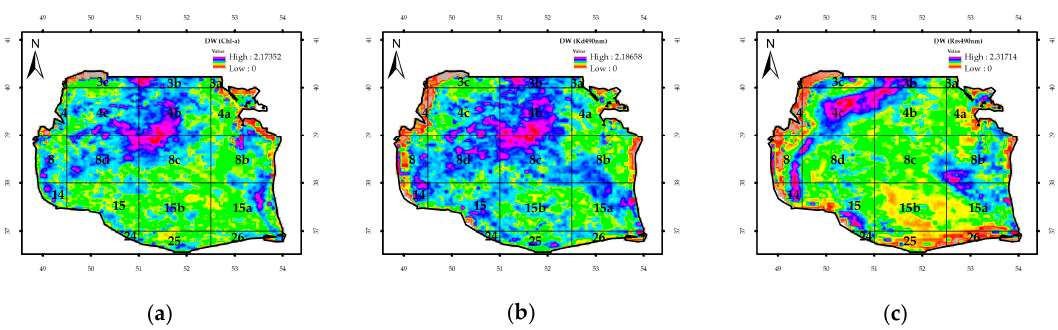
Figure A1. Column Durbin–Watson statistics for bio-optical parameters in the Southern Caspian Sea: ( a ) Chl-a, ( b ) attenuation coe ffi cient, and ( c )